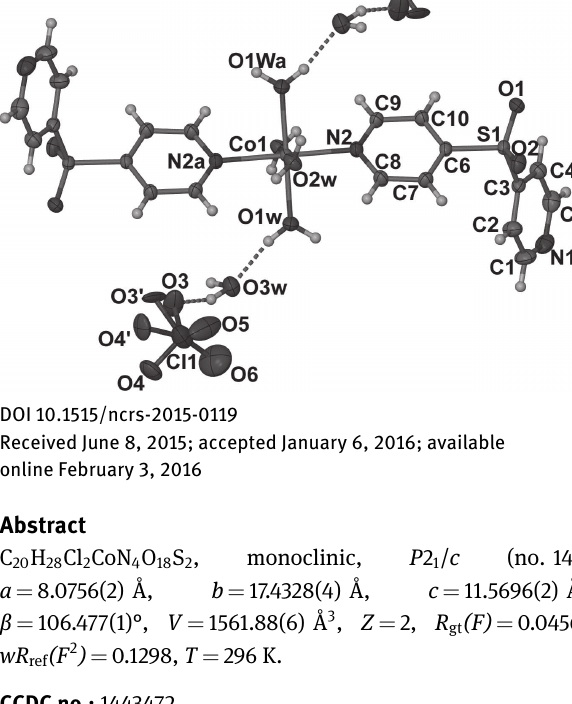
Table 1: Data collection and handling. Crystal: